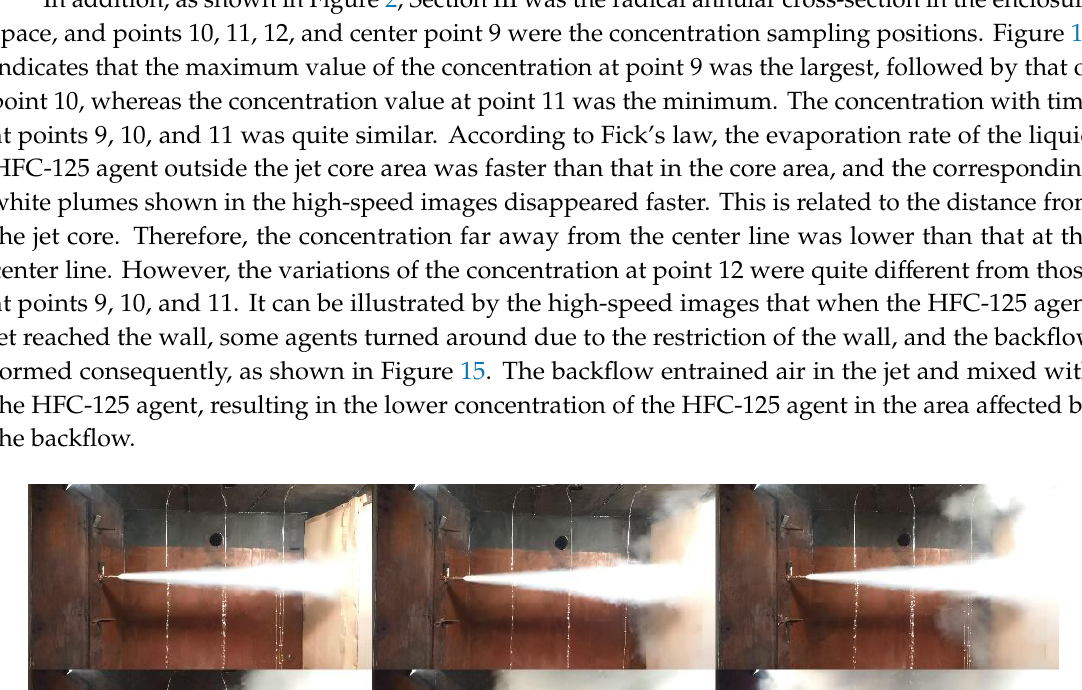
Figure 15. The backflow recorded by the high-speed camera.